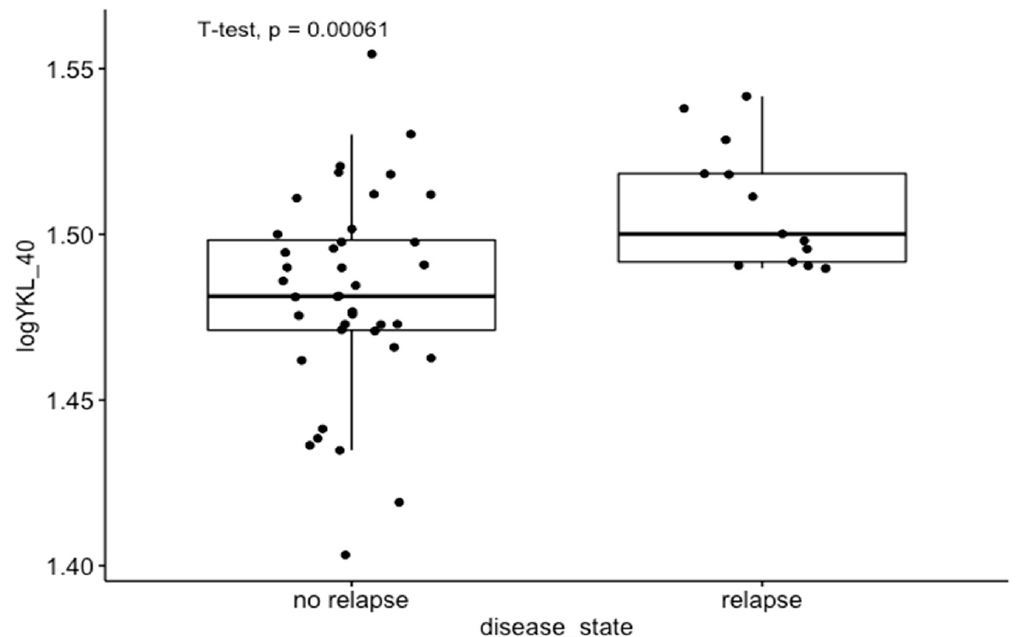
Figure 1. Correlations between the expression of YKL-40, MMP8, PD-L1, and IL17A in GEO datasets GDS4382 ( A – C , F ) and GDS4515 ( D , E ).